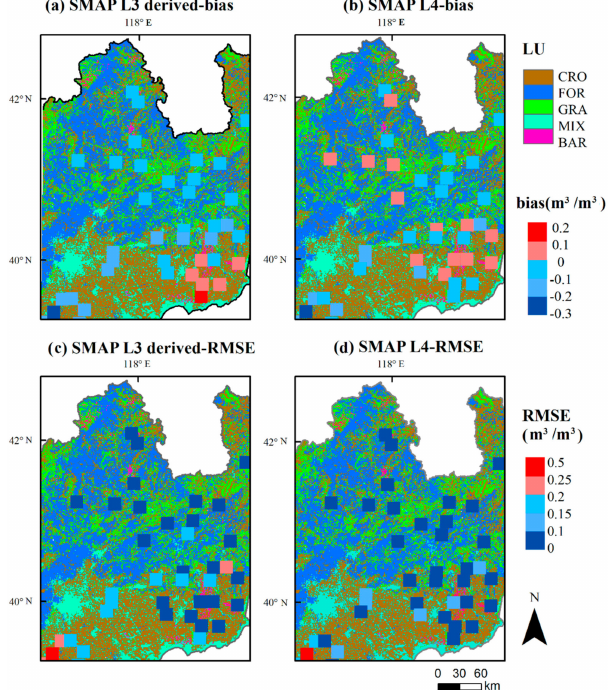
Figure 10. Spatial distribution of bias and RMSE among different land uses zoomed from the red rectangle area in Figure 9. (Note that the zoomed area is mainly the northern part of Haihe River basin in